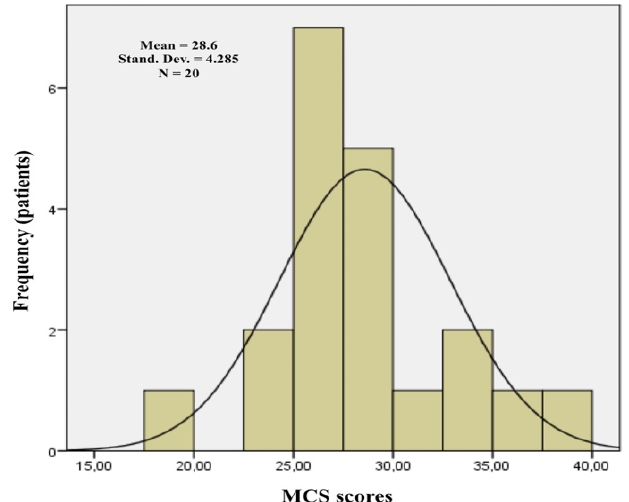
Figure 2. Mental Component Summary (MCS) histogram (created by SPSS software for Windows, release